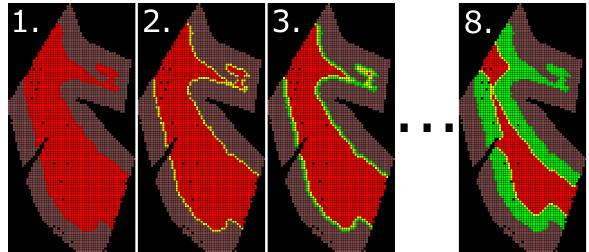
Figure 8. Iterative processing of the measuring area from shore to water center. Brown = land grid cells. Yellow = currently processed grid cell. Red = non processed grid cells. Green = processed grid cells.